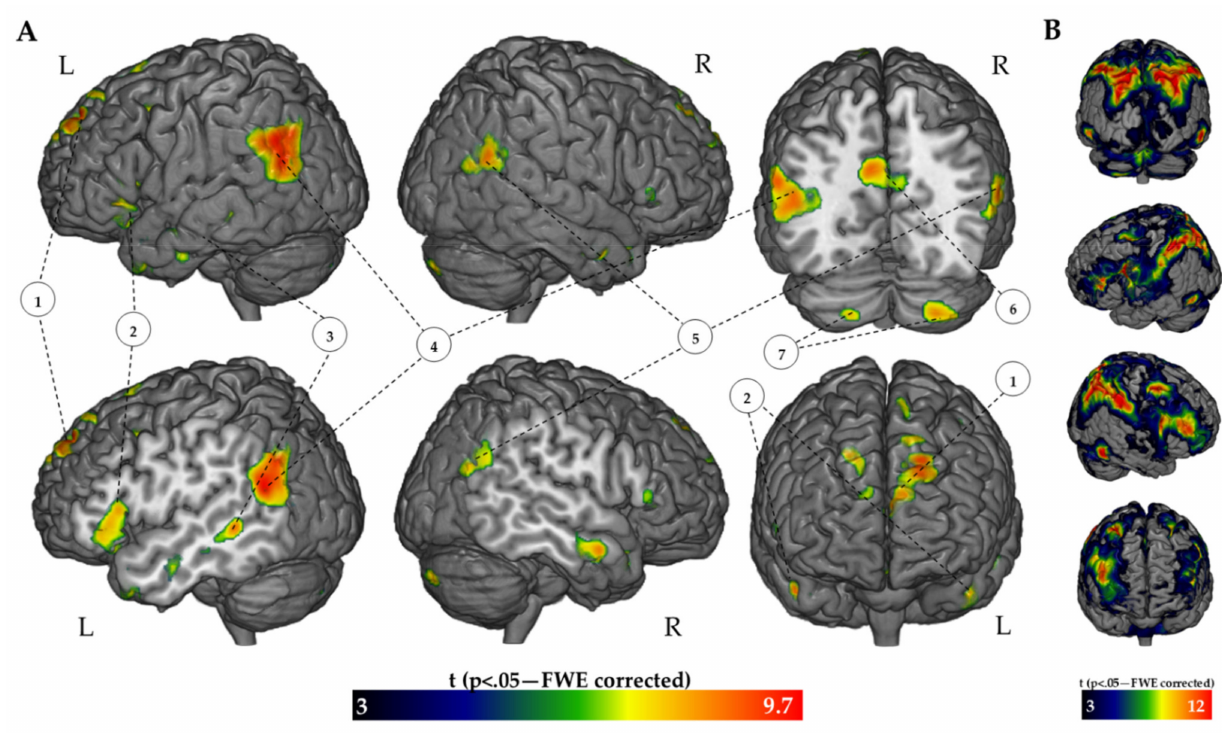
Figure 1. Threshold activation maps of the FR > BC contrast ( A ) and of the BC > FR contrast ( B ). The regions are displayed on the 3D rendered MNI reference brain (statistical threshold of p < 0.05 FWE-corrected; cluster size: >50). 1: Bilateral Superior/Medial Frontal Gyrus; 2: Left Inferior Frontal Gyrus; 3: Left Middle Temporal Gyrus 4: Left IPL; 5: Right IPL; 6: PCC and Precuneus; 7: Bilateral Cerebellum. Table 1. MNI coordinates for each region, showing an increased BOLD signal in the FR > BC